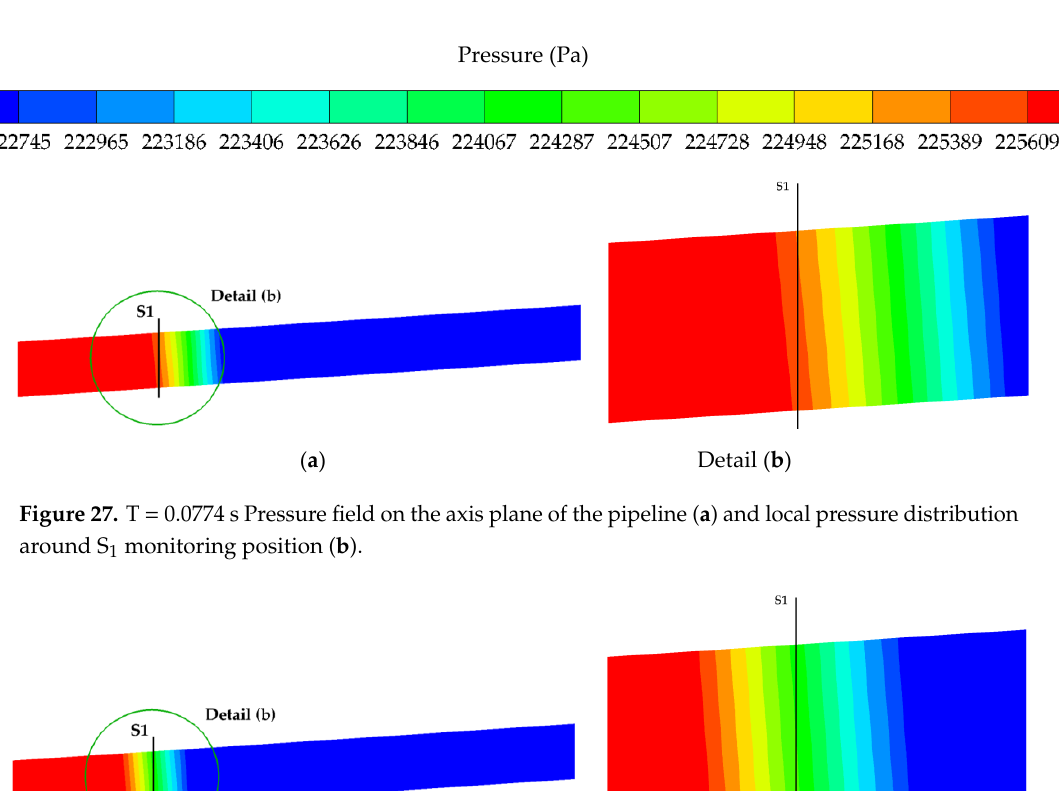
Figure 26. Comparison between Computational Fluid Dynamics (CFD) simulation results and experimental data.